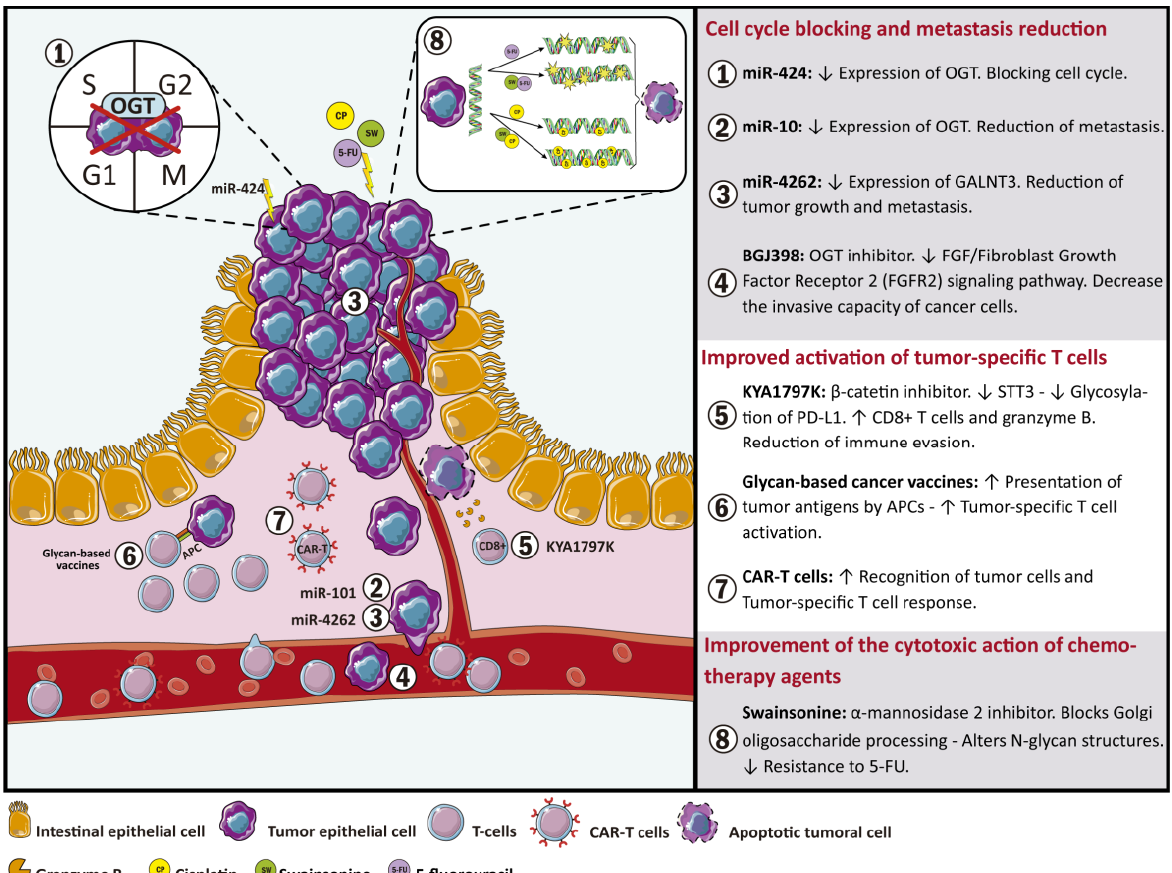
Figure 1. Glycan-based therapeutic approaches for colorectal cancer. Details of therapy strategies based on modifications of glycan and glycosyltransferase expression includes: (1–4) Glycosyltransferases as a target for therapeutic miRNAs and glycosyltransferase inhibitors in order to reduce metastasis and block cell cycle. (5–7) Strategies based on glycan profile modifications to stimulate the immune system. (8) Implementation of modified glycan structures to increase cytotoxic action of chemotherapy agents.